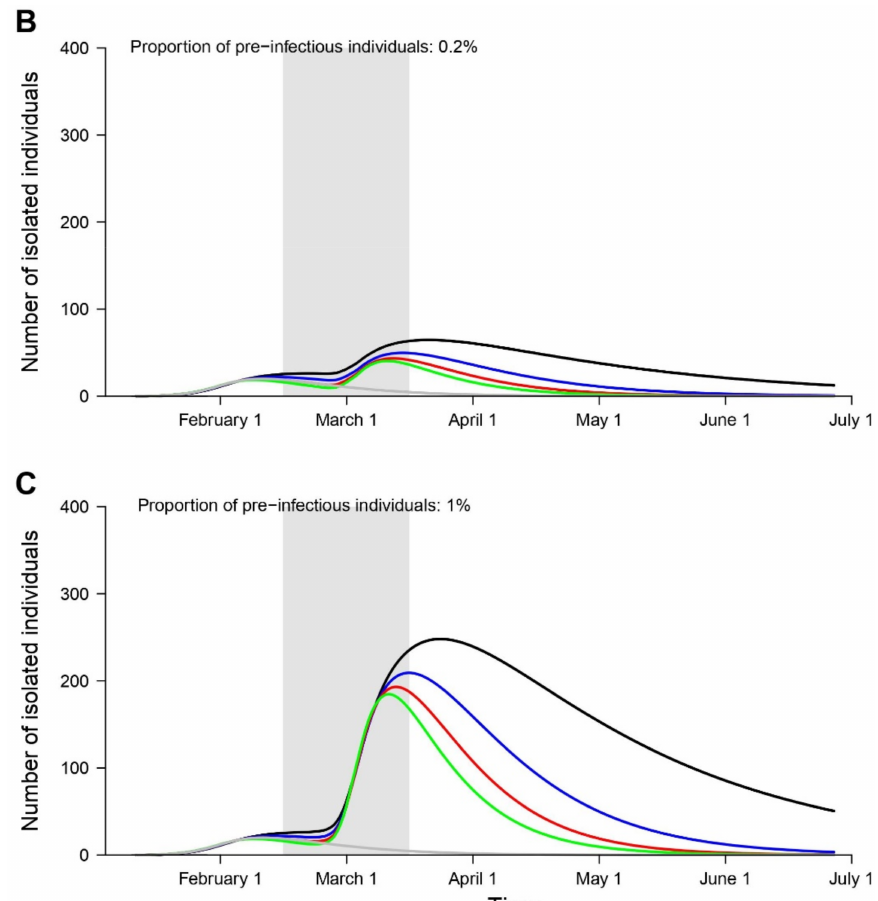
Figure 3. Estimated daily number of isolated individuals in Seoul, South Korea, under di ff erent scenarios regarding the proportion of pre-infectious individuals: 0.1% ( A ), 0.2% ( B ), or 1% ( C ) based on di ff erent compliance rates with home-quarantine (gray: baseline, black: 70%, blue: 80%, red: 90%, green: 100%). Shaded gray bars represent the period of arrival of the international students from China, the country with the risk of 2019 novel coronavirus on February